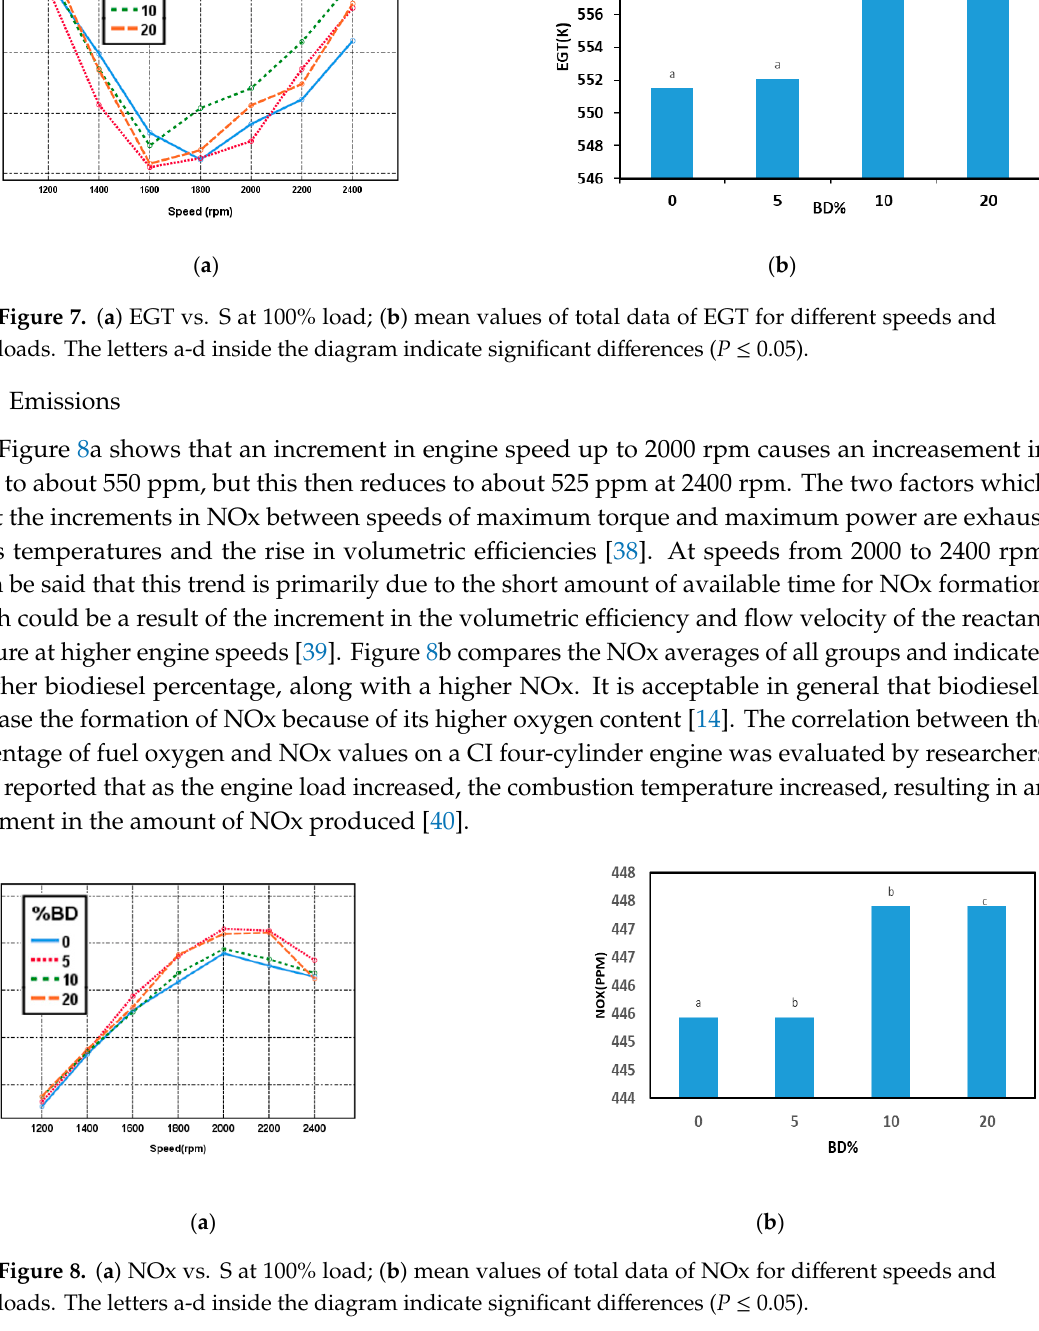
( b ) Figure 9. ( a ) CO 2 vs. S at 100% load; ( b ) mean values of total data of CO 2 for different speeds and loads. The letters a-d inside the diagram indicate significant differences ( P ≤ 0.05). Unanimous conclusions exist about the effects of engine speed on CO emissions. The higher the engine speed, the less the CO emission. The air/fuel ratio plays a key role in CO emissions. Reducing